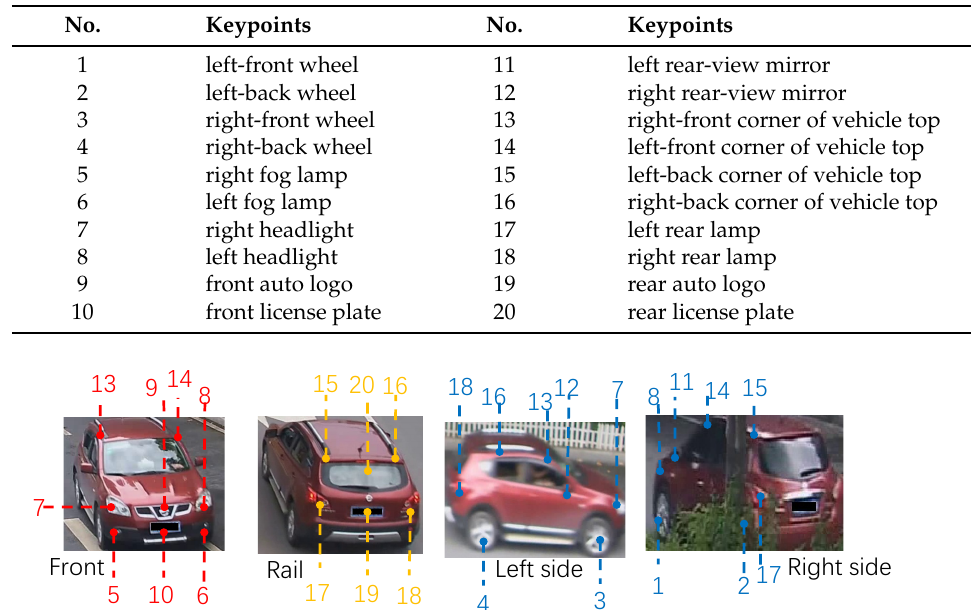
Table 1. The annotations of 20 keypoints on vehicle.